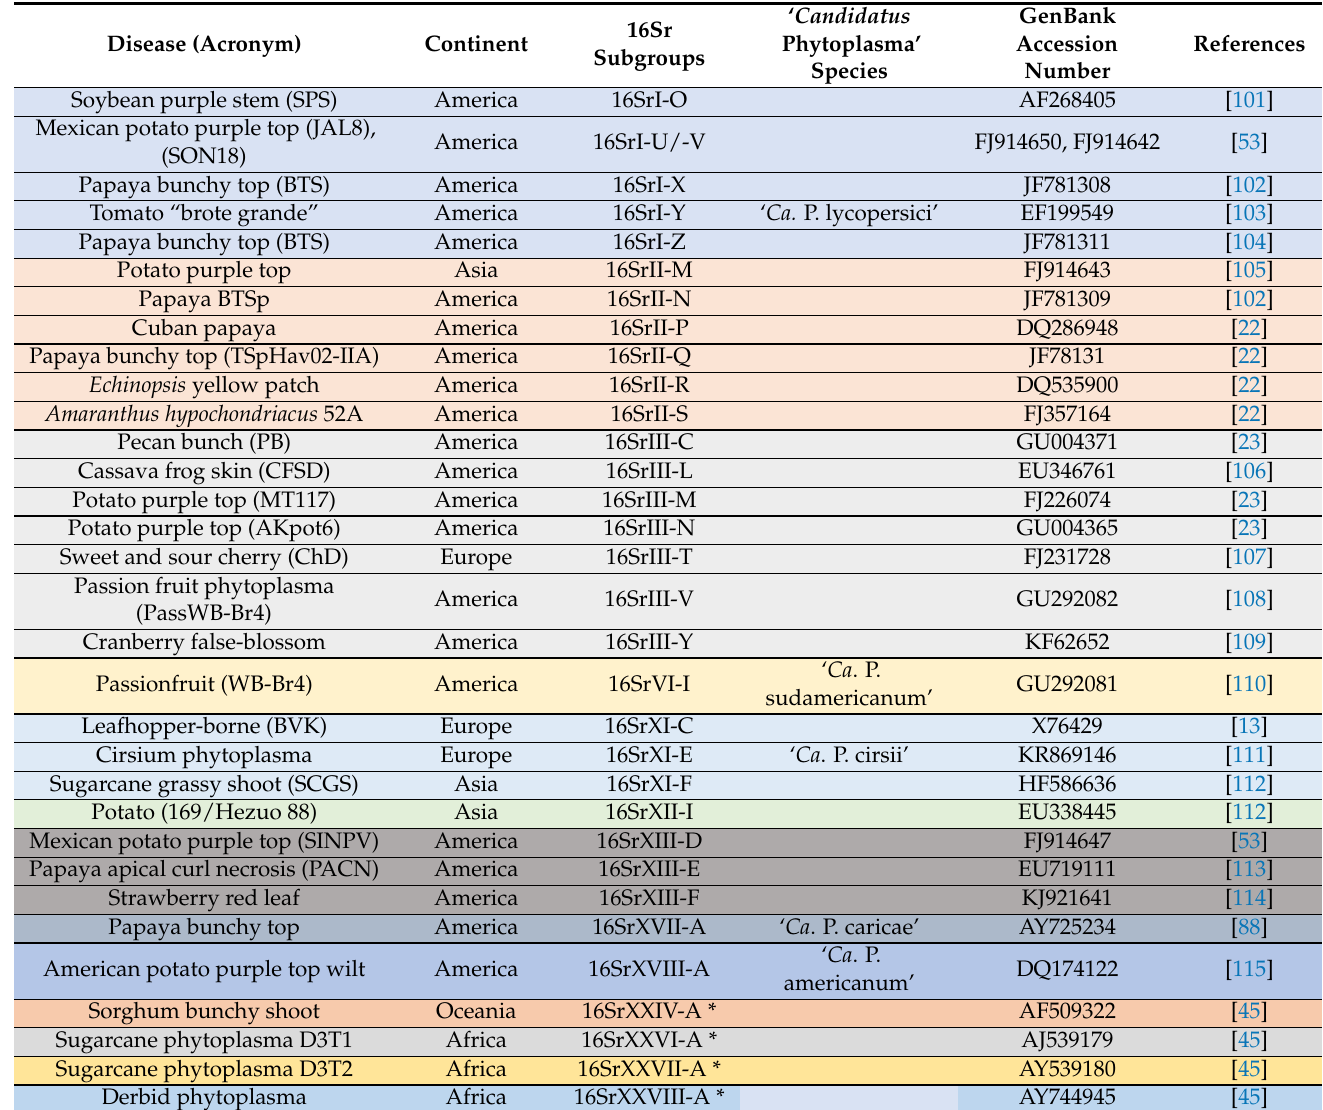
Table 6. Molecular diversity and geographic distribution of selected phytoplasmas belonging to different ribosomal groups/‘ Candidatus Phytoplasma’ species (marked by different color) associated with purple top and other